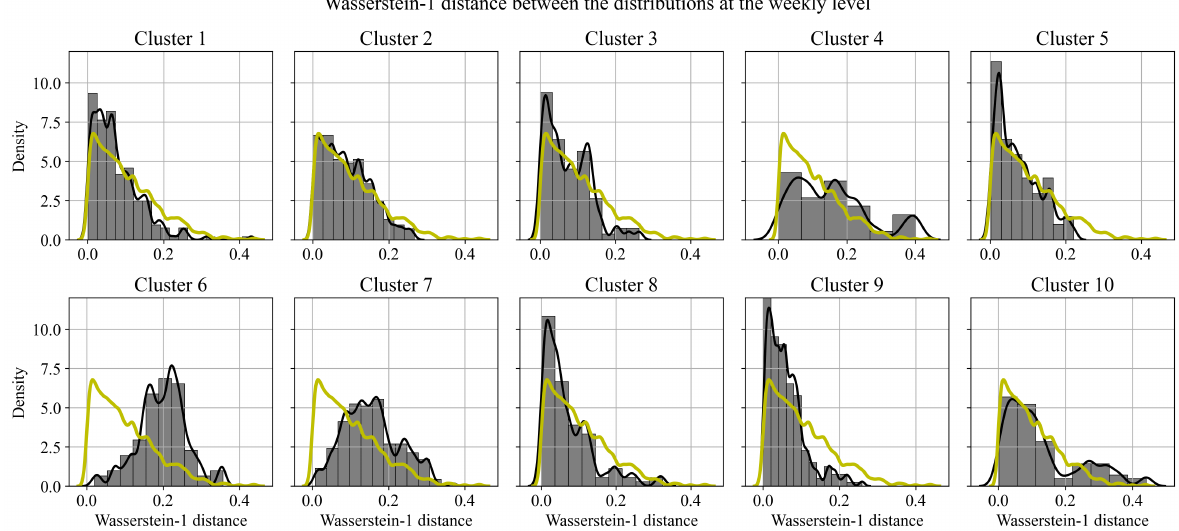
Figure 13. Histograms of the Wasserstein-1 distance between the distributions of the consumption and peak demands probability functions at the weekly level. The black plot denotes the density for the individual cluster, while the plot in yellow indicates the density of the full